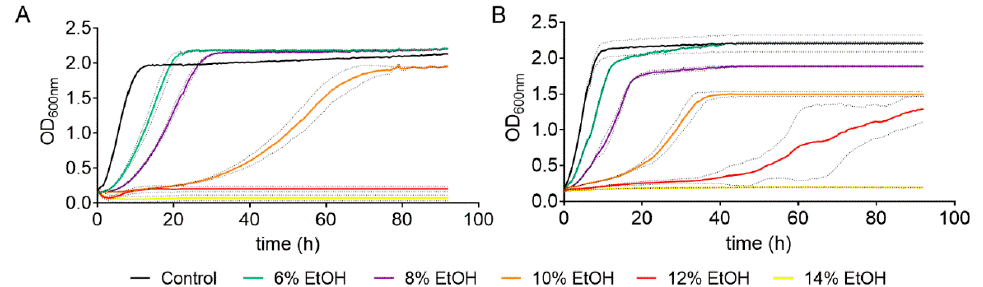
Figure 1. Effect of different ethanol concentrations on the cell growth of S. cerevisiae strains BY4743 ( A ) and QA23 ( B ). Ethanol concentrations: 0% (black), 6% (green), 8% (purple), 10% (orange), 12% (red), and 14% (yellow). Standard deviations were indicated with dotted lines.